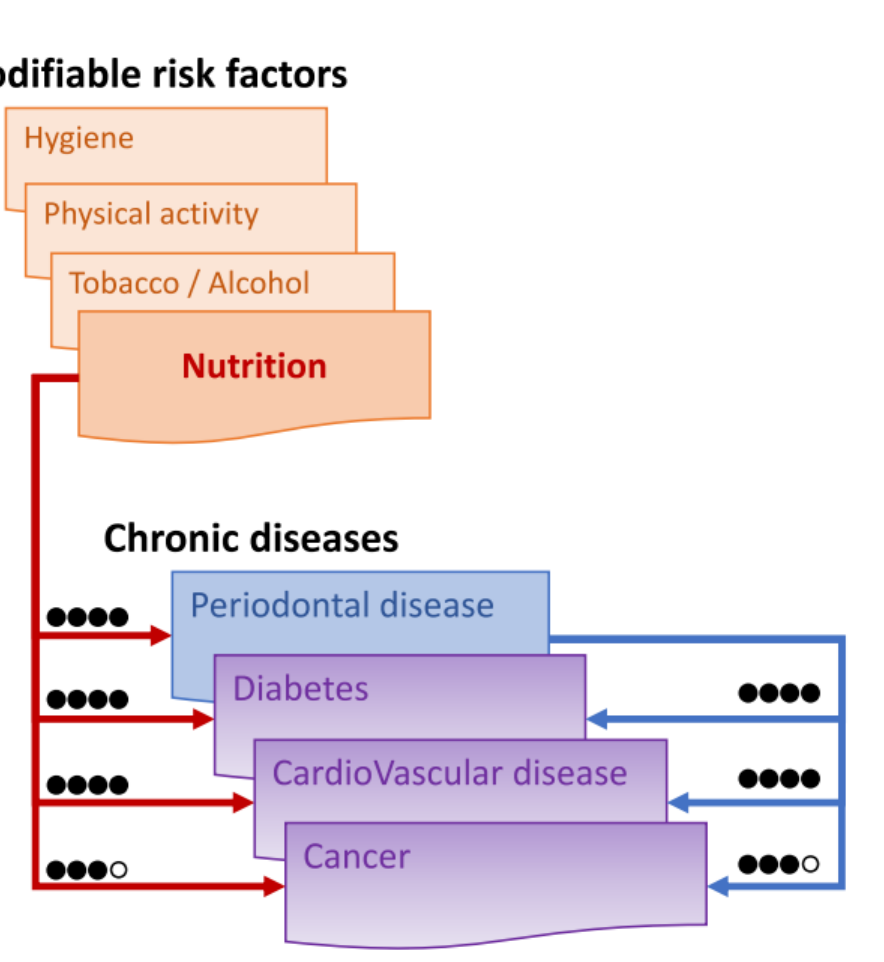
Figure 3. Assessment of the links between nutrition, periodontitis and other main chronic